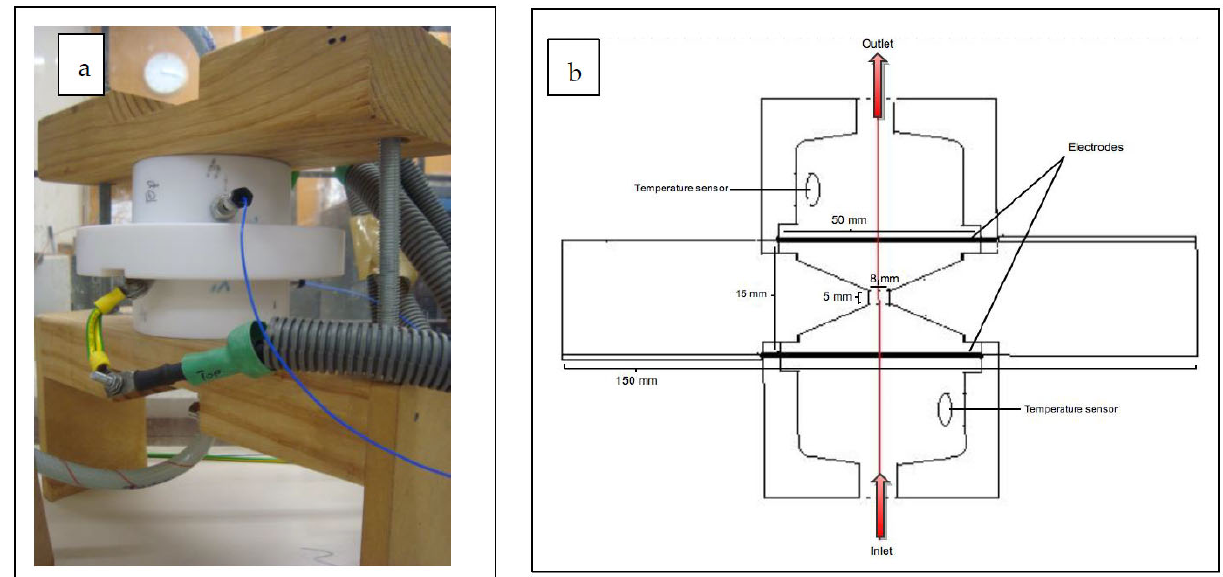
Figure 3. ( a ) The treatment chamber designed and constructed at the University of Auckland [24,25]. ( b ) Cross-sectional view of the treatment chamber.